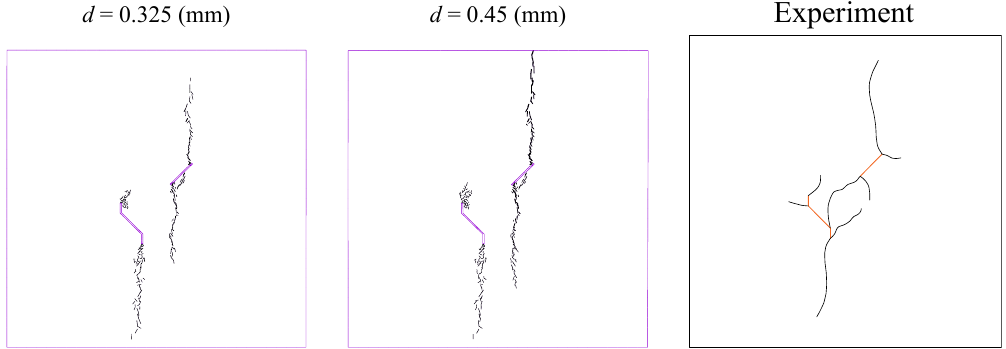
Figure 15. 3D-printed materials with two intermittent fissures ( α = − 45 ◦ ): the crack opening plots (deformation scale 1:1) compared to the experimental results provided in [84].